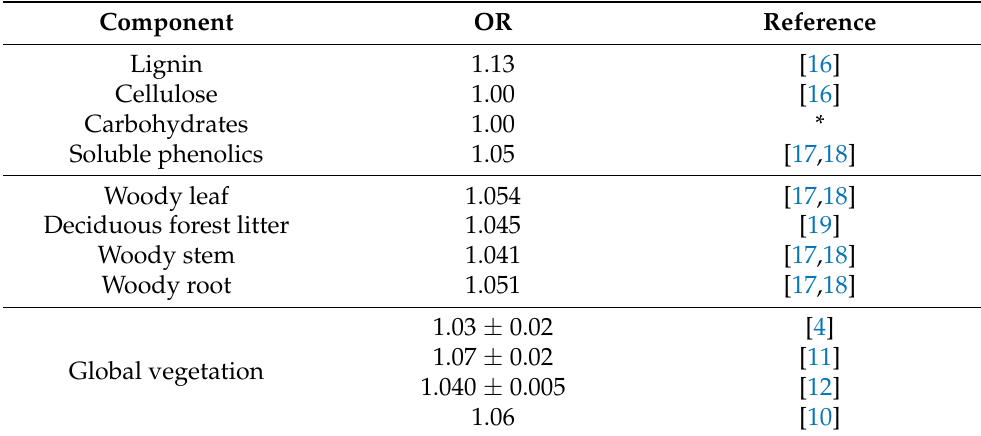
Table 1. Oxidative ratios (ORs) of common plant components, woody leaf, deciduous forest lit- ter, woody stem and woody root and calculated OR for global terrestrial vegetation. * OR for carbohydrates is calculated from the empirical formula C m (H 2 O) n